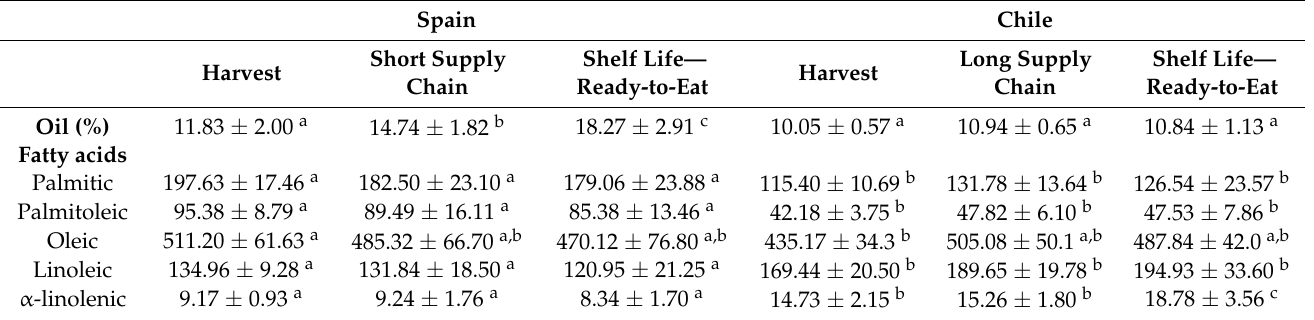
Table 2. Oil and fatty acids content in Hass avocado from two countries (Spain and Chile) at harvest, after short and long-supply chains, and at the-ready-to-eat stage. Spain